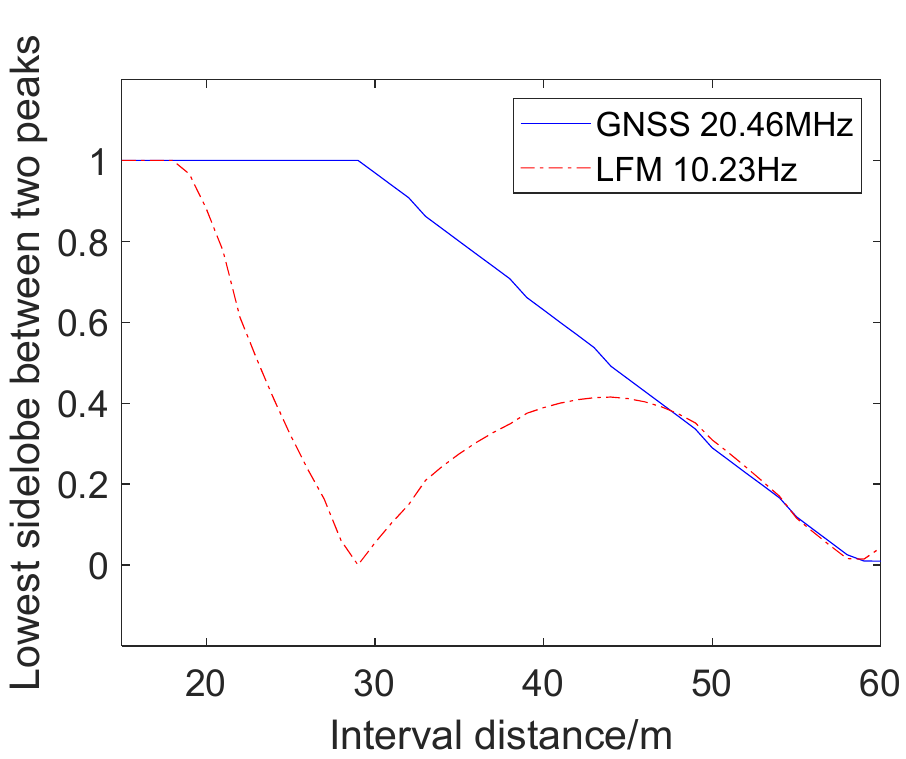
Figure 5. Sidelobe between two main lobe peak ratios of the B3I and chirp signals.